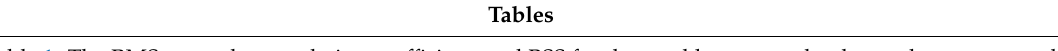
Table 1. The RMS error, the correlation coe ffi cient, and BSS for the weekly averaged volume-change rate and the cumulative volume change in the calibration process. Table 2. The RMS error, the correlation coe ffi cient, and BSS for the weekly averaged volume-change rate and the cumulative volume change in the validation process. Figures Figure 1. Location of study site. Figure 2. Plan view of the study area and the survey line. The contour lines are based on the survey data on 11 November 1996. Figure 3. Mean beach profile and the profiles at the beginning and end of the investigation period from x = − 115 to 40 m along the survey line indicated in Figure 2. Figure 4. Temporal variation of the cumulative volume change in the investigation area based on the beach profile measured on 5 January 1987. Figure 5. Coordinate system. Figure 6. Monthly averaged wind characteristics: (a) absolute wind velocity and wind direction and (b) wind-velocity components in cross-shore and alongshore directions. The positive cross-shore and alongshore wind velocities are landward and southward, respectively. Figure 7. Yearly averaged wind characteristics. See Figure 6 for further explanation. Figure 8. Monthly averaged amounts of precipitation. Figure 9. Yearly averaged amounts of precipitation. Figure 10. Photos of vegetation in a square mesh taken on 24 June 1996 (a) and 14 January 1997 (b). Figure 11. Monthly averaged Cveg1. Figure 12. Time series of Cveg2,N and Cveg2,S. Figure 13. Photos of vegetation along and around the survey line taken on 2 August 1995 (a) and 1 June 2007 (b). The broken lines display the survey line. Figure 14. Correlation between the measured and simulated weekly averaged volume-change rates in the calibration process. Figure 15. Time series of the measured and simulated cumulative volume changes in the calibration